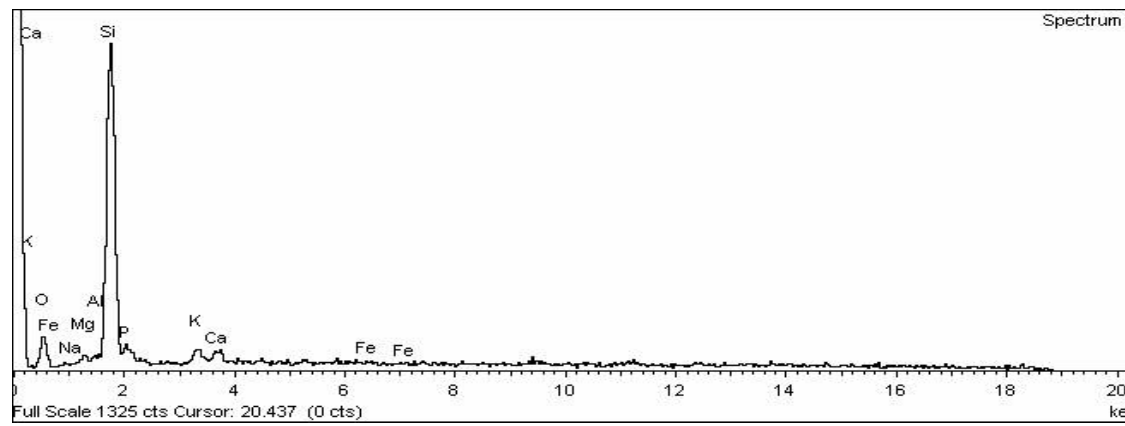
Figure 1. EDX analysis graph of RHA. Table 2. Elemental analysis of RHA.